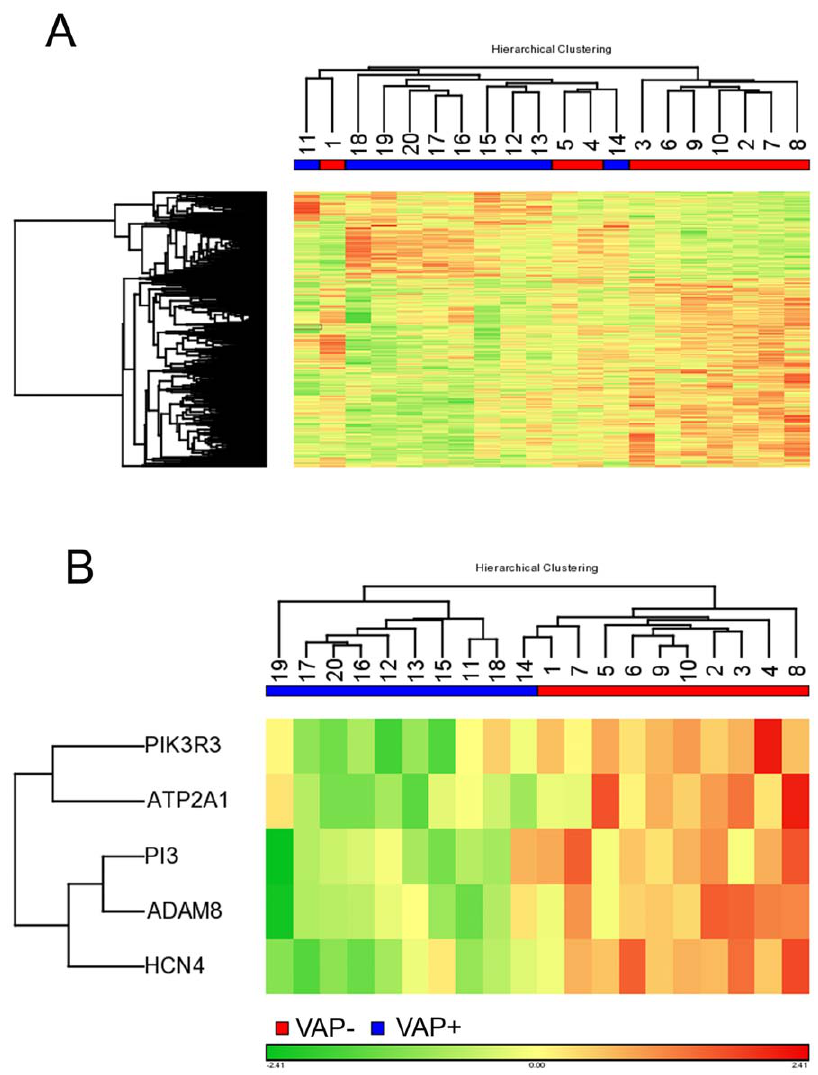
Figure 1. Hierarchical clustering of VAP 2 and VAP + patients. (a) Hierarchical clustering of 810 differentially expressed genes in patients that went on to develop ventilator-associated pneumonia (blue) and those that did not (red). (b) Hierarchical clustering with the five genes that were common to all sets used in the cross validation tests.